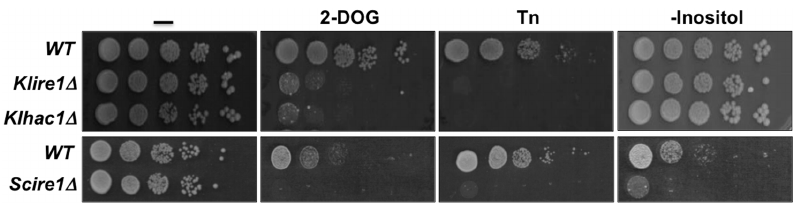
Figure 5. ( Top ) Diagram of the precursor and processed forms of K. lactis HAC1 RNA. Exon and intron